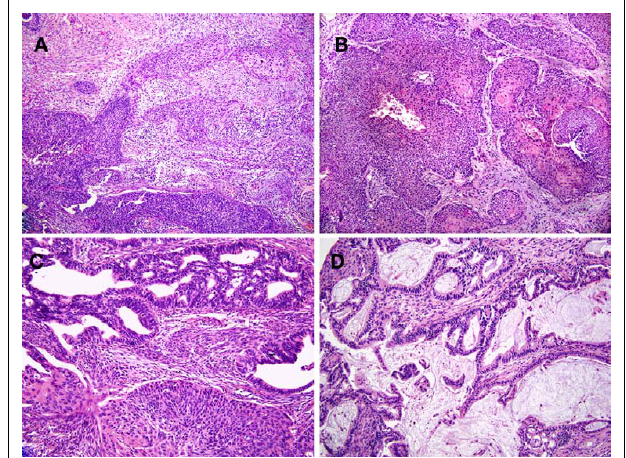
FIGURE 2 | Human papilloma viruses-16 + cervical cancer tumor samples display a variety of pathologies. Histopathology of tumor samples stained with hematoxylin and eosin. (A,B) are representatives of squamous cell carcinoma samples.The tumor sample shown in (A) (KTS2) is an invasive, moderate to poorly differentiated squamous cell carcinoma (200 × ).The tumor sample in (B) (KTS9) represents an invasive, moderately differentiated squamous cell carcinoma but with focal keratinization (right; 100 × ).The remaining two samples shown are adenocarcinomas with or without squamous features [ (C,D) , respectively, 200 × ]. (C) Shows an adeno-squamous carcinoma (KTS5), demonstrating glandular differentiation with a squamous component and exhibiting the sheet growth characteristics of squamous epithelium. (D) Shows a mucin producing, invasive adenocarcinoma (KTS8). Results are from pathology slides prepared from nine different tumors.